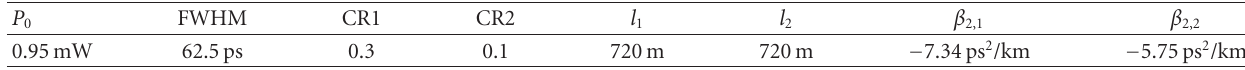
Table 1: Doublet generation’s parameters.